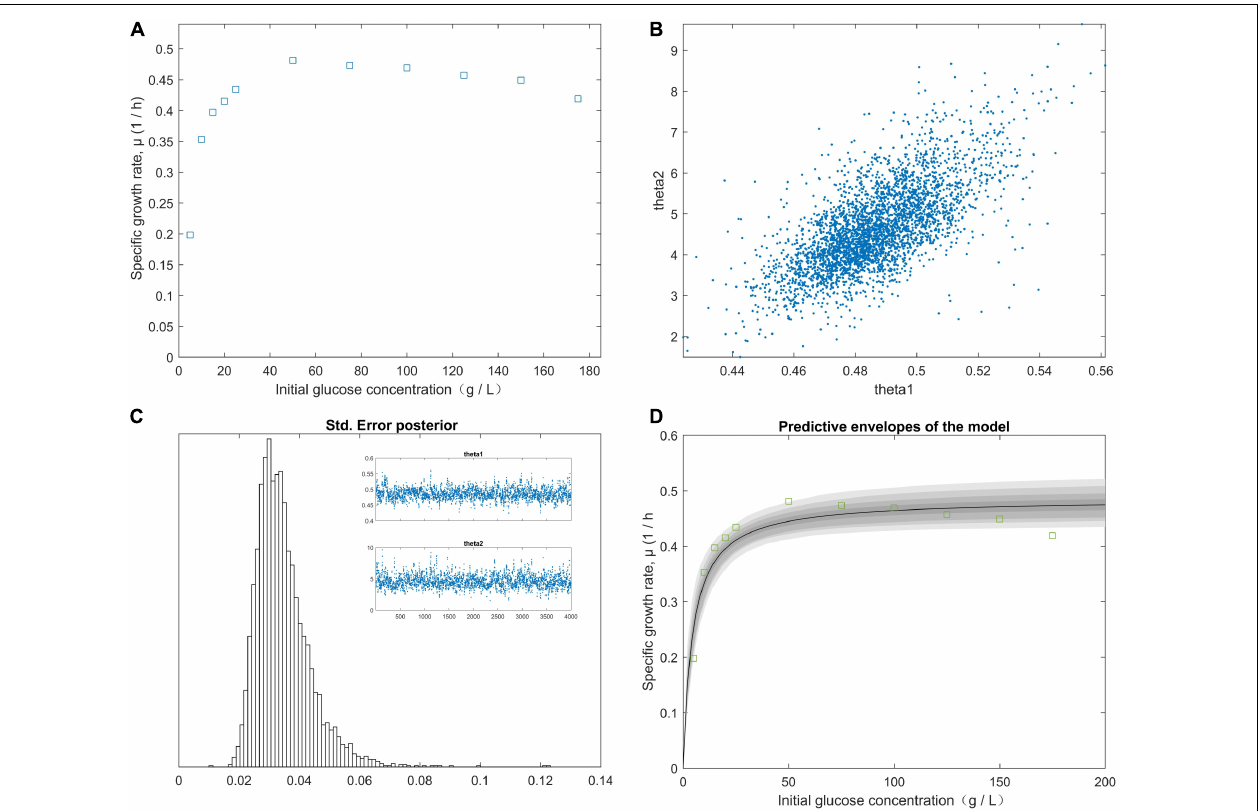
FIGURE 2 | The effect of the initial glucose concentration gradient from predictive posterior distribution on the specific growth rate of the C. tyrobutyricum mutant. (A) The different specific growth rates of C. tyrobutyricum mutant correlated with the initial glucose concentration gradient. (B) Chain plots, plots 1 and 2, and dimensional marginal kernel density estimates of the posterior distributions. (C) Standard deviation was displayed at the square root of the s2chain. Top right figures: the 1D parameter chains with 4.0 × 10 3 consecutive steps of delayed-rejection adaptive metropolis MCMC. (D) Predictive envelopes of the model: The gray protection system corresponds to 50, 90, 95, and 99% in the posterior regions as illustrated in the plot.